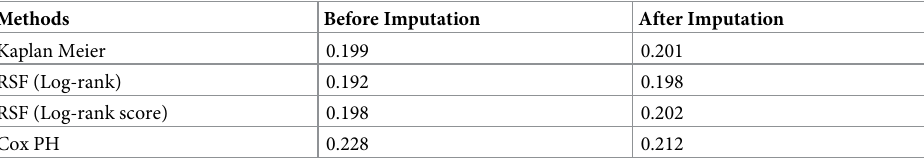
Table 6. Comparison of the models using the integrated brier